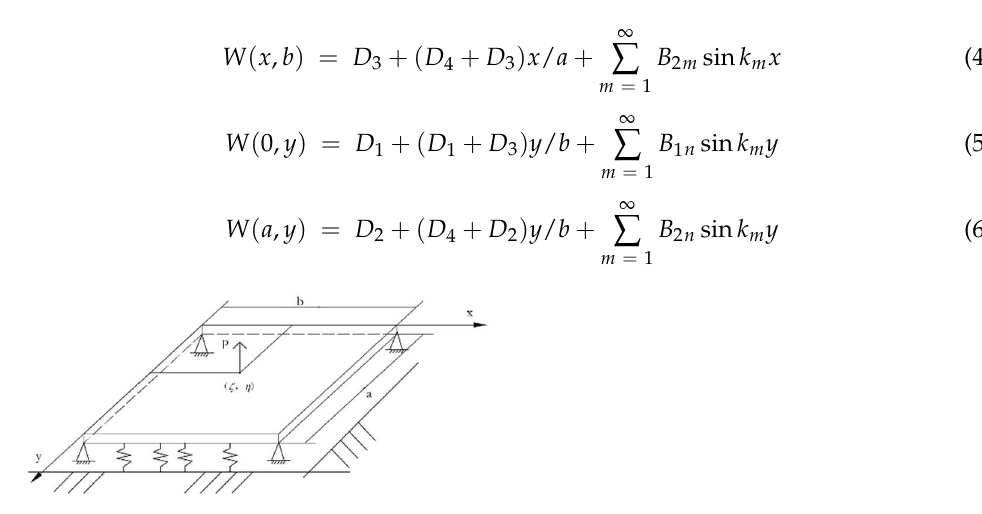
Figure 2. Vibration plate with four edges free.